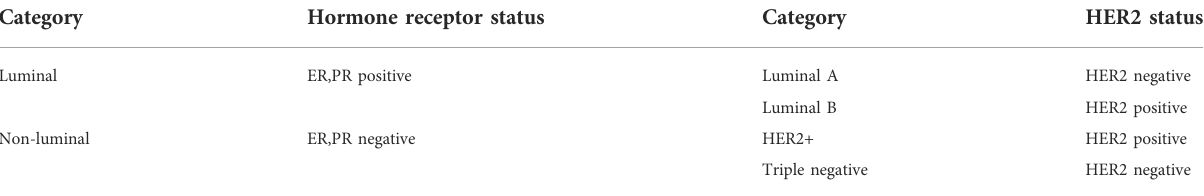
TABLE 5 Classi fi cation of breast